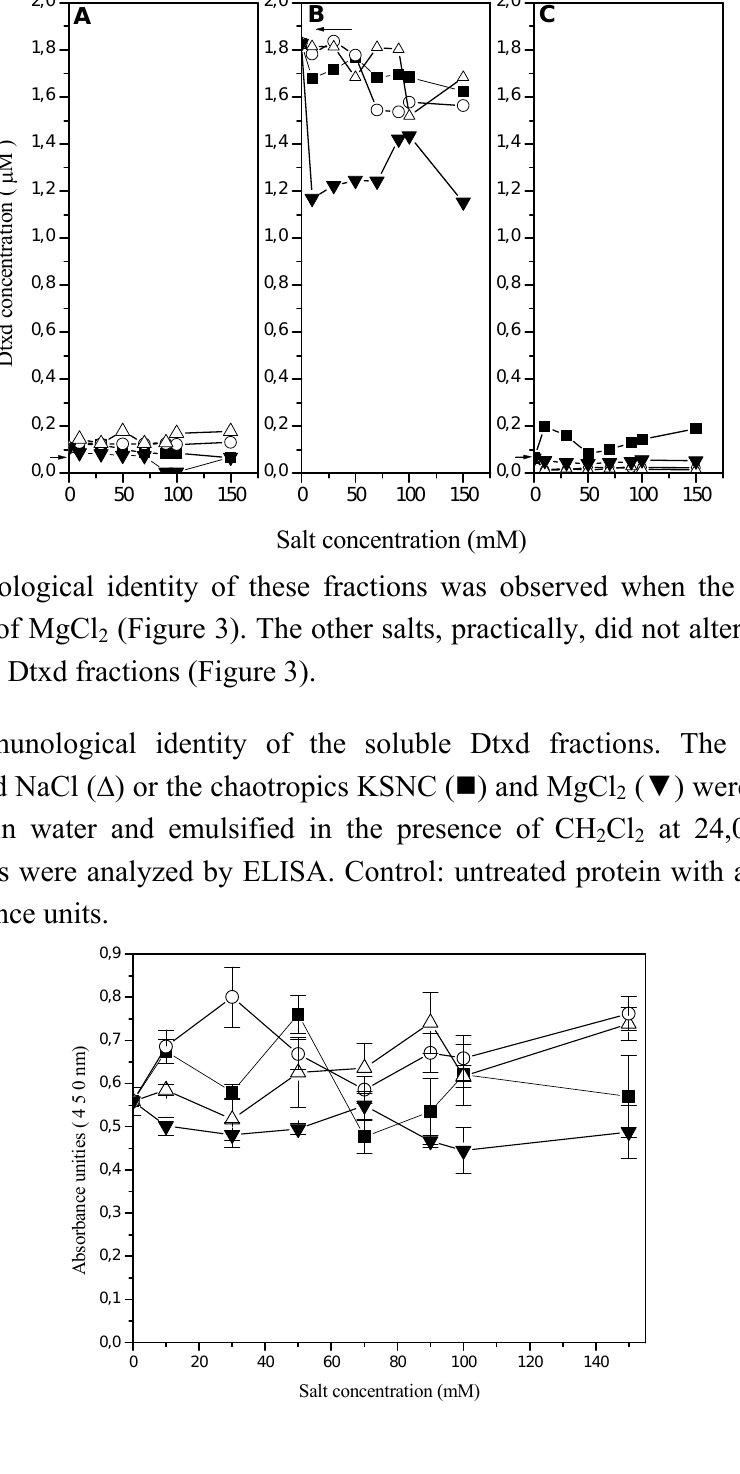
Figure 2. Effect of Hoffmeister series ions in different Dtxd molecular species after emulsification in the presence of CH Cl . The kosmotropics NaHPO (o) and NaCl ( ∆ ) or 2 2 4 the chaotropics KSNC ( (cid:132) ) and MgCl ( ▼ ) were added to the Dtxd water solutions and 2 emulsified in the presence of CH Cl at 24,000 rpm. A. Dtxd dimmer, B. Dtxd monomer 2 2 and C. Fragments A and B. Controls: Dtxd emulsified without salt and methylene chloride (arrows in the pictures). The soluble Dtxd molecular species fractions were analyzed by HPLC gel filtration (QC-PACK GFC 300 column - 7.8 mm X 15 cm) previously equilibrated with PBS, at 20 °C. Injection and elution flows were 0.6 mL/min.